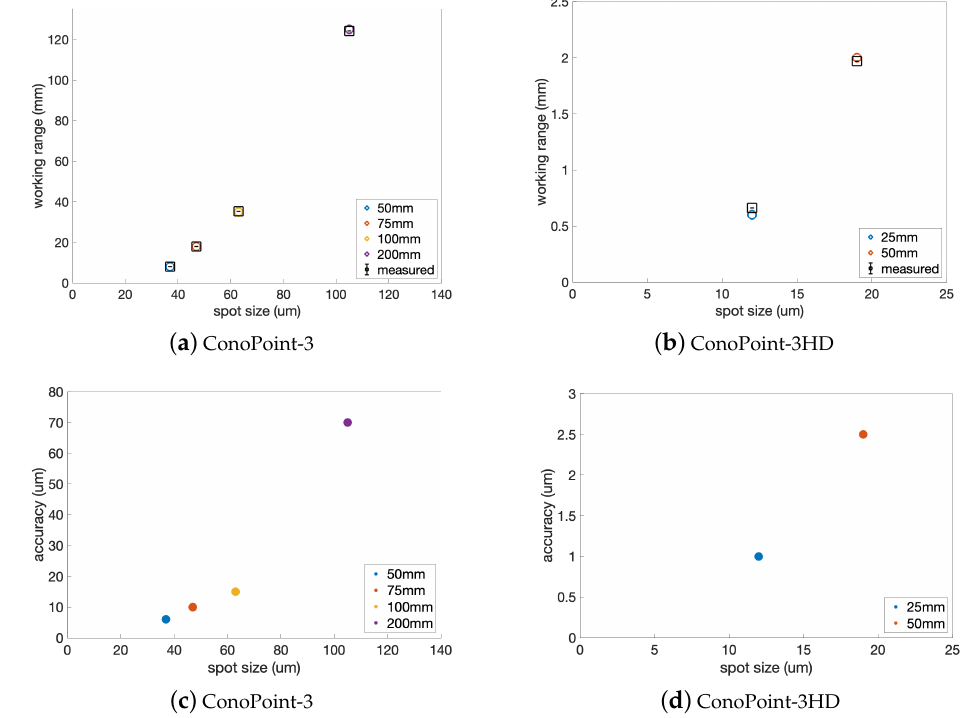
Figure 3. Performance analysis of the different lens-probe coupling. ( a , b ) Working range variation versus laser spot variation. The working range has been measured on a flat diffusive standard, the nominal value is also reported. ( c , d ) Dependence of depth accuracy on laser spot. Setups: ConoPoint-3 (lenses: 16 mm, 50 mm, 75 mm, 100 mm, 200 mm); ConoPoint-3HD (lenses: 25 mm, 50